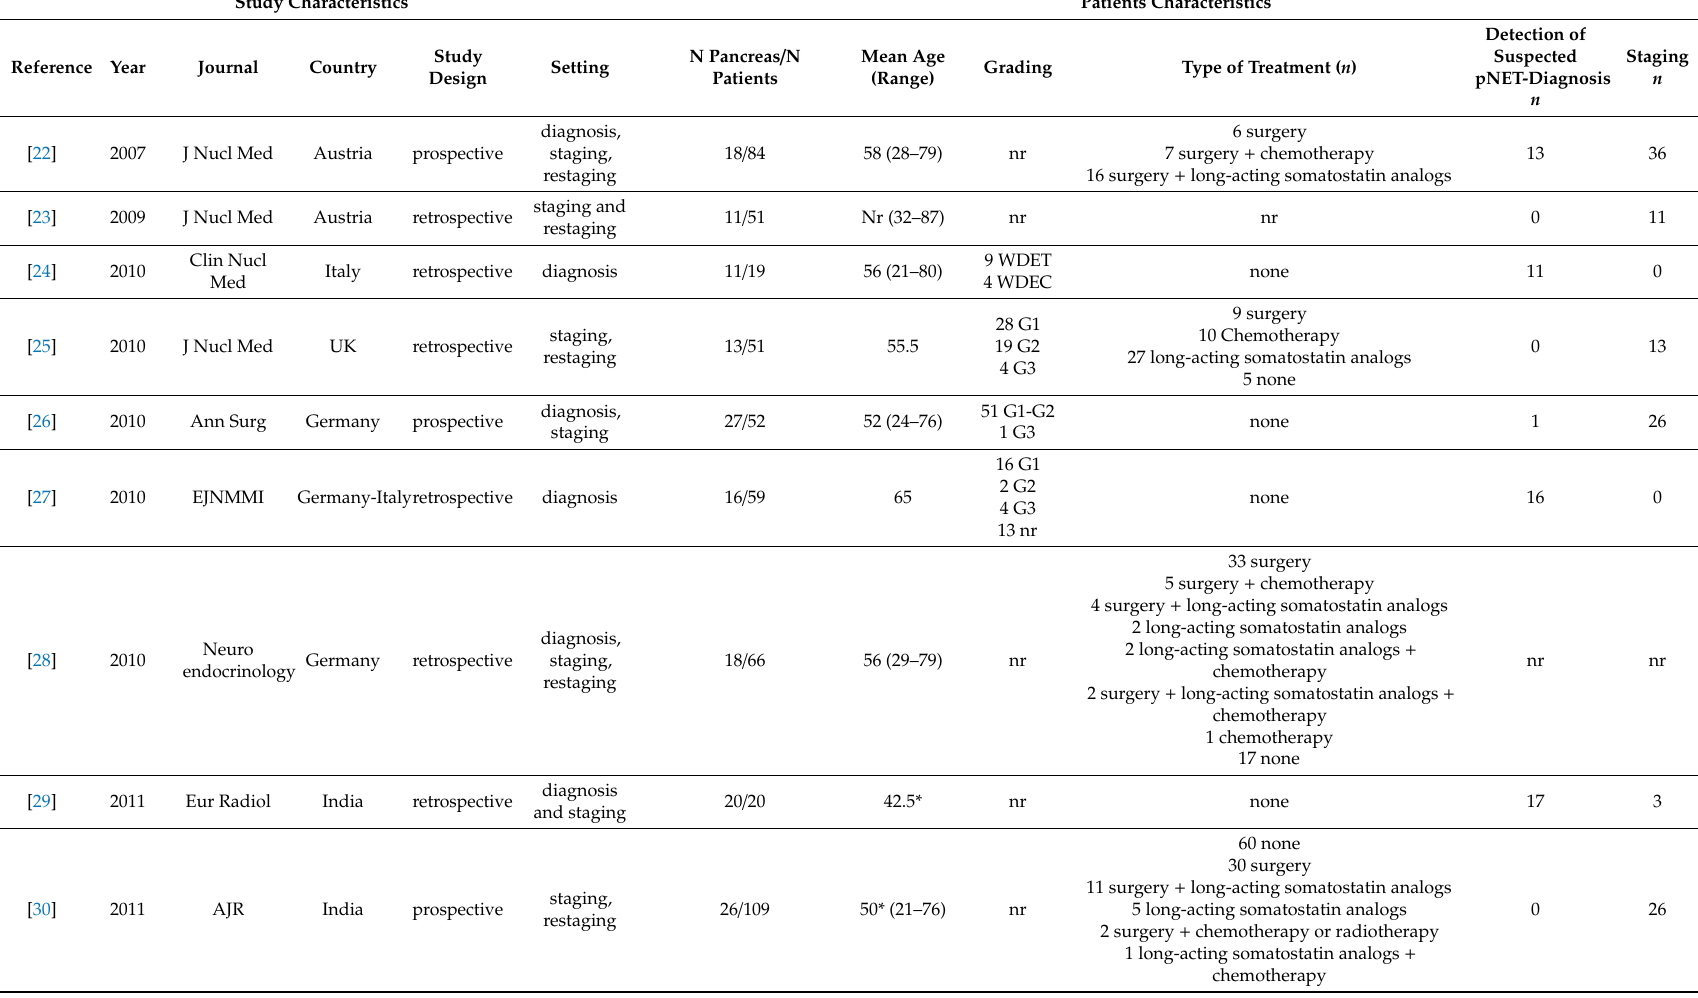
Table 1. Characteristics of included